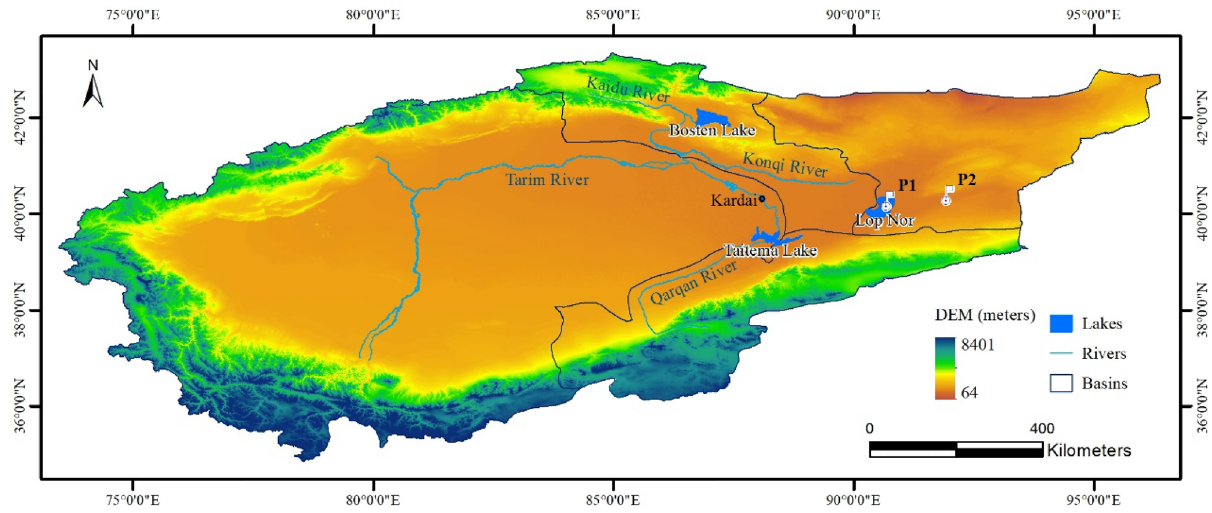
Figure 1. Digital terrain and surface water system of the Tarim River Basin (P1, P2 are groundwater field observation locations). This figure was generated by ArcGIS v10.7 software (Environmental Systems Research Institute, Inc., USA, URL: http:// www. esri. com/). Kendall’s tau p value (two-tailed)